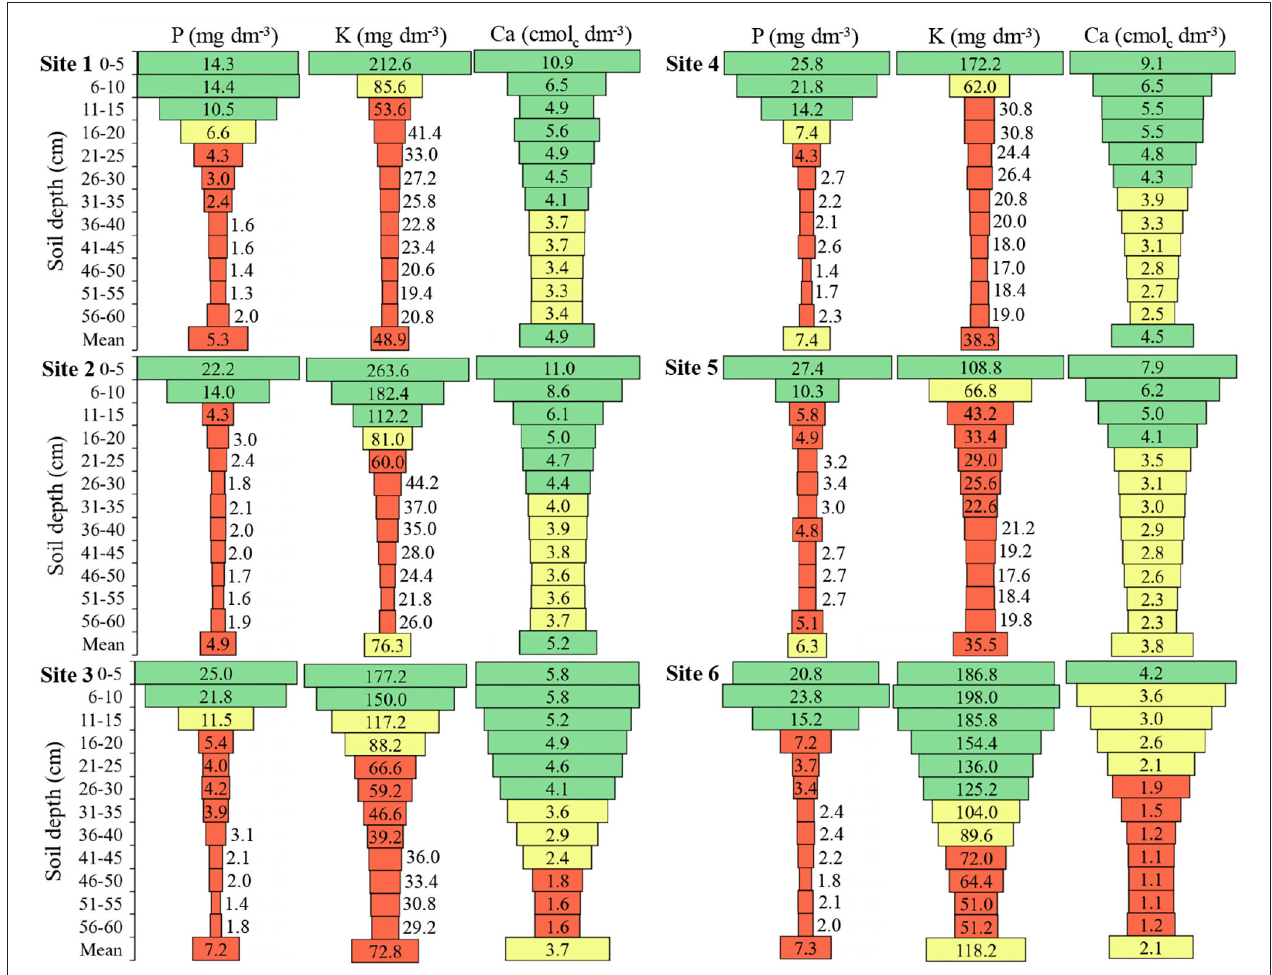
FIGURE 3 | Phosphorus (P), potassium (K), and calcium (Ca) in the six sites and at different soil depths. To Sites 1, 2, 4 , and 5 : Green color: adequate values (P ≥ 9.1; K ≥ 91.0); Yellow color: intermediate values (P 6.1–9.0; K 61–90); Red color: inadequate values (P ≤ 6.0; K ≤ 60). To Sites 3 and 6 : Green color: adequate values (P ≥ 12.1; K ≥ 121); Yellow color: intermediate values (P 8.1–12.0; K 81–120); Red color: inadequate values (P ≤ 8.0; K ≤ 80) to soils of South of Brazil ( CQFS,